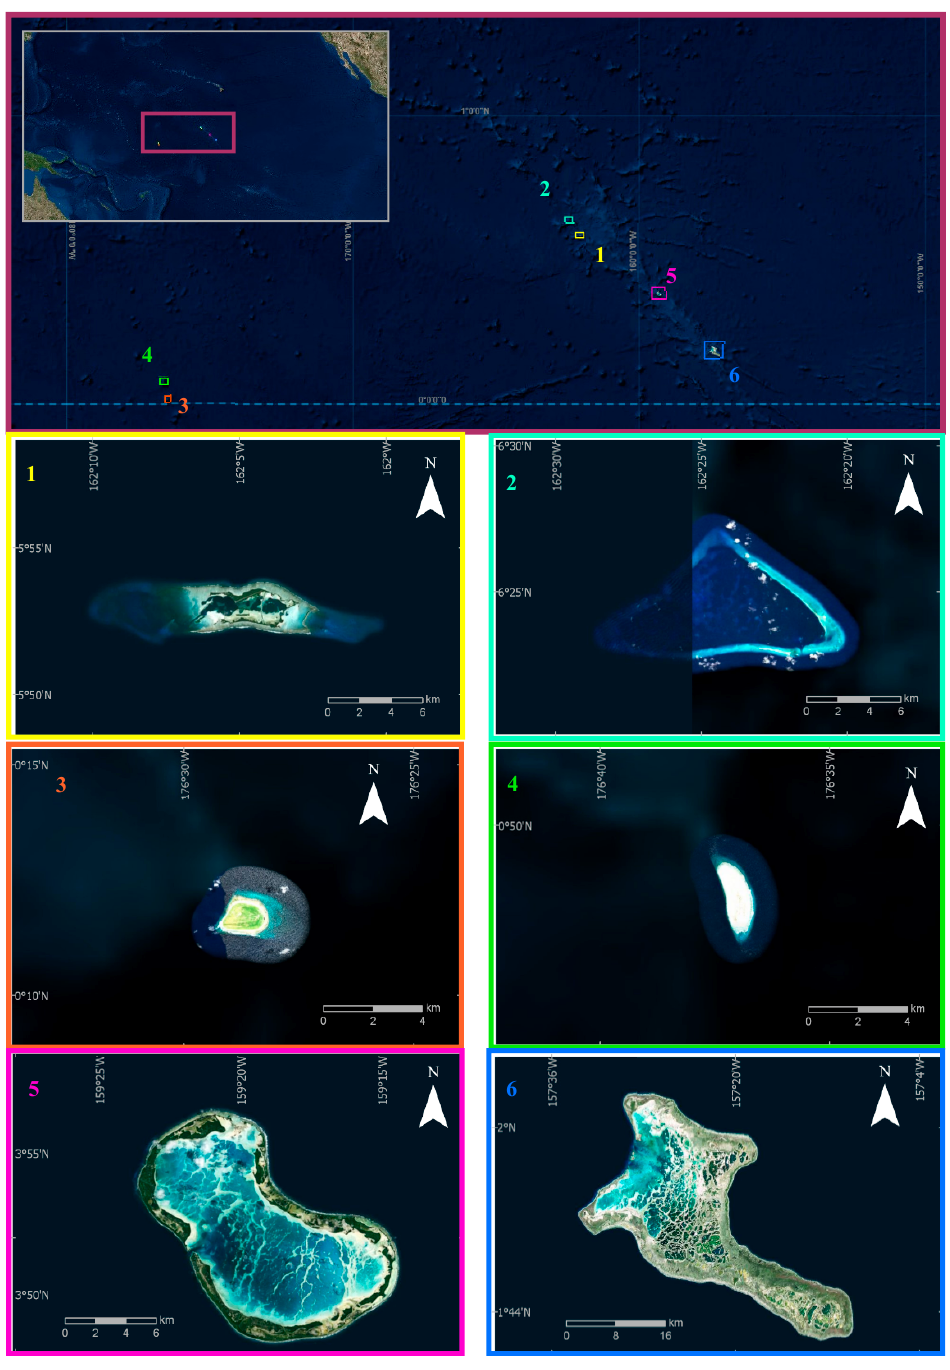
Figure 1. The relative location of each of the six sites ( a ) Palmyra Atoll, ( b ) Kingman Reef, ( c ) Baker Island Atoll, ( d ) Howland Island, ( e ) Tabuaeran Island, and ( f ) Kiritimati Island.